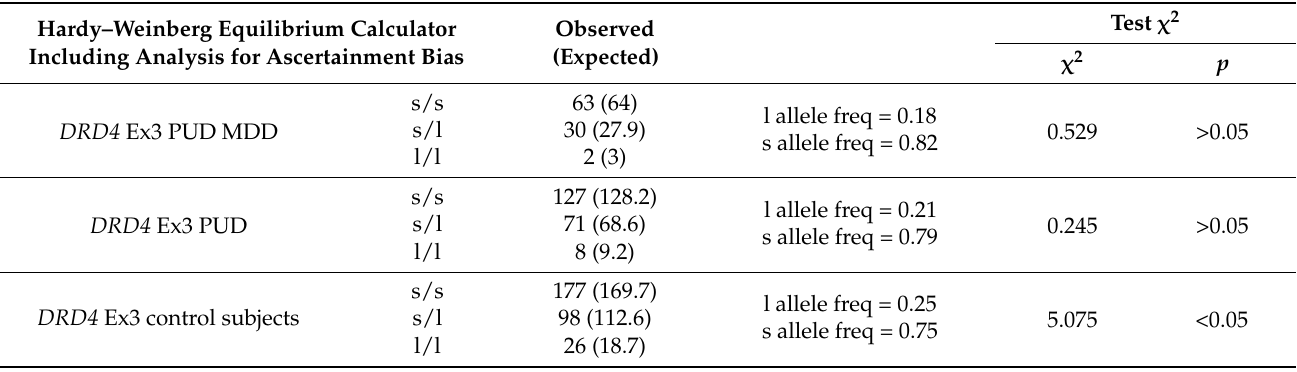
Table 2. Hardy–Weinberg’s law for patients with polysubstance use disorder comorbid with a depressive episode (PUD MDD), for patients diagnosed with polysubstance use disorder (PUD) and control subjects.